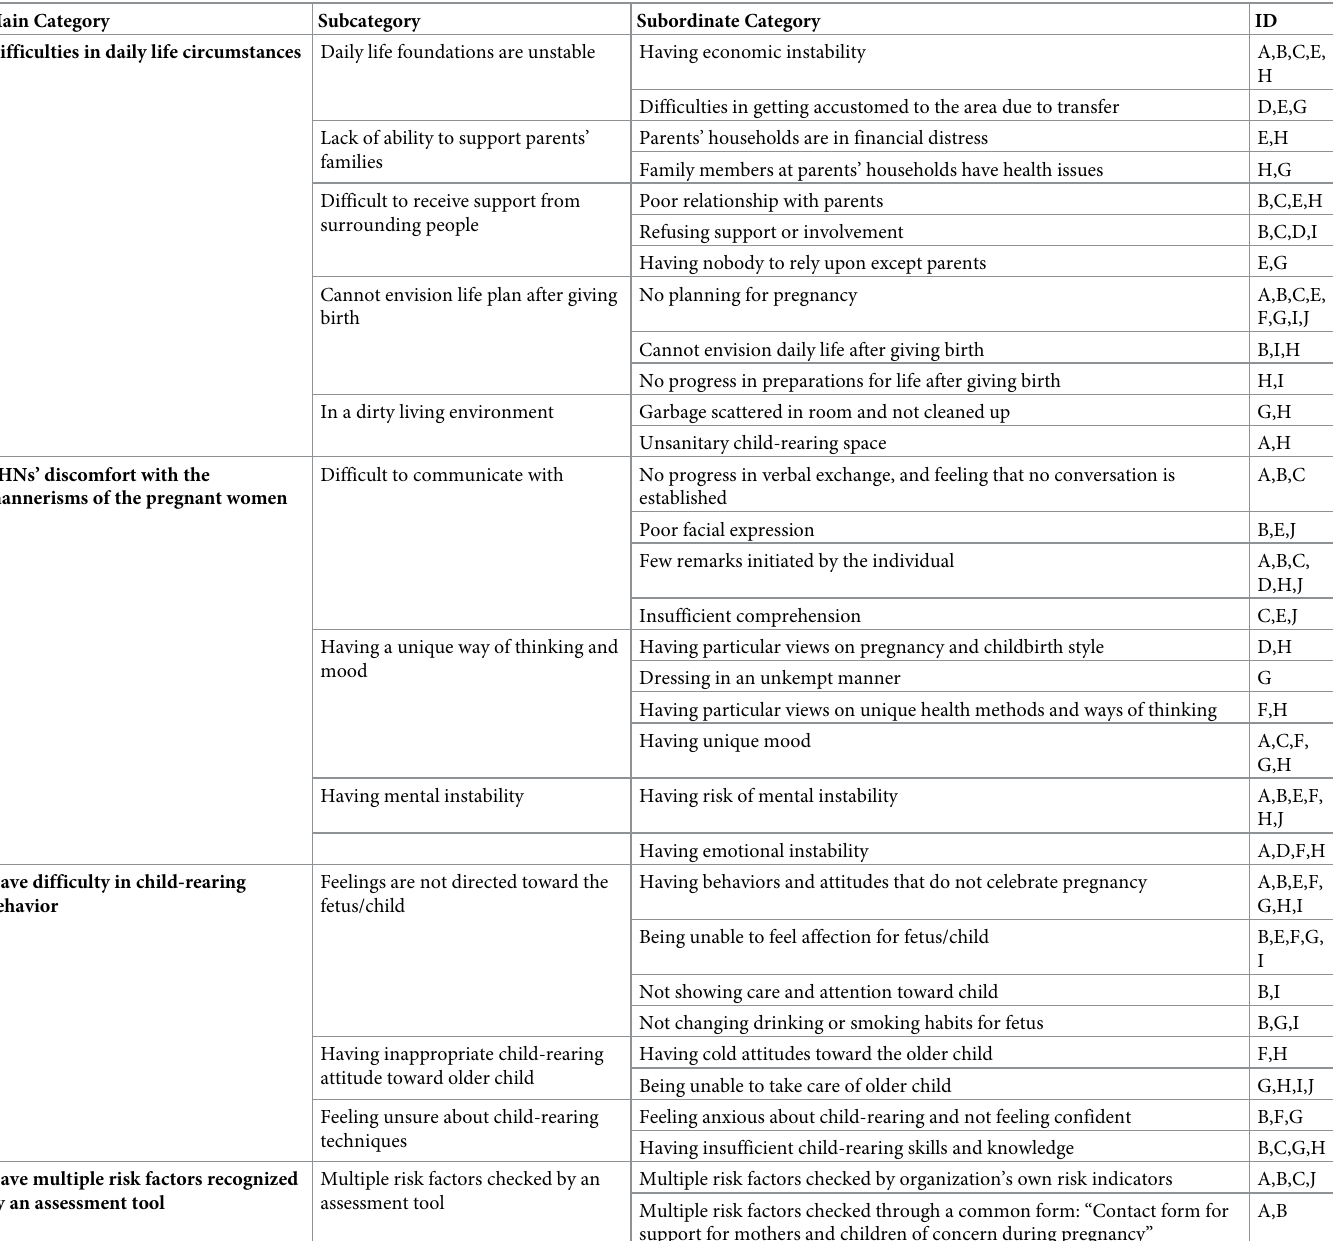
Table 2. Characteristics of pregnant and postpartum women of concern as observed by public health